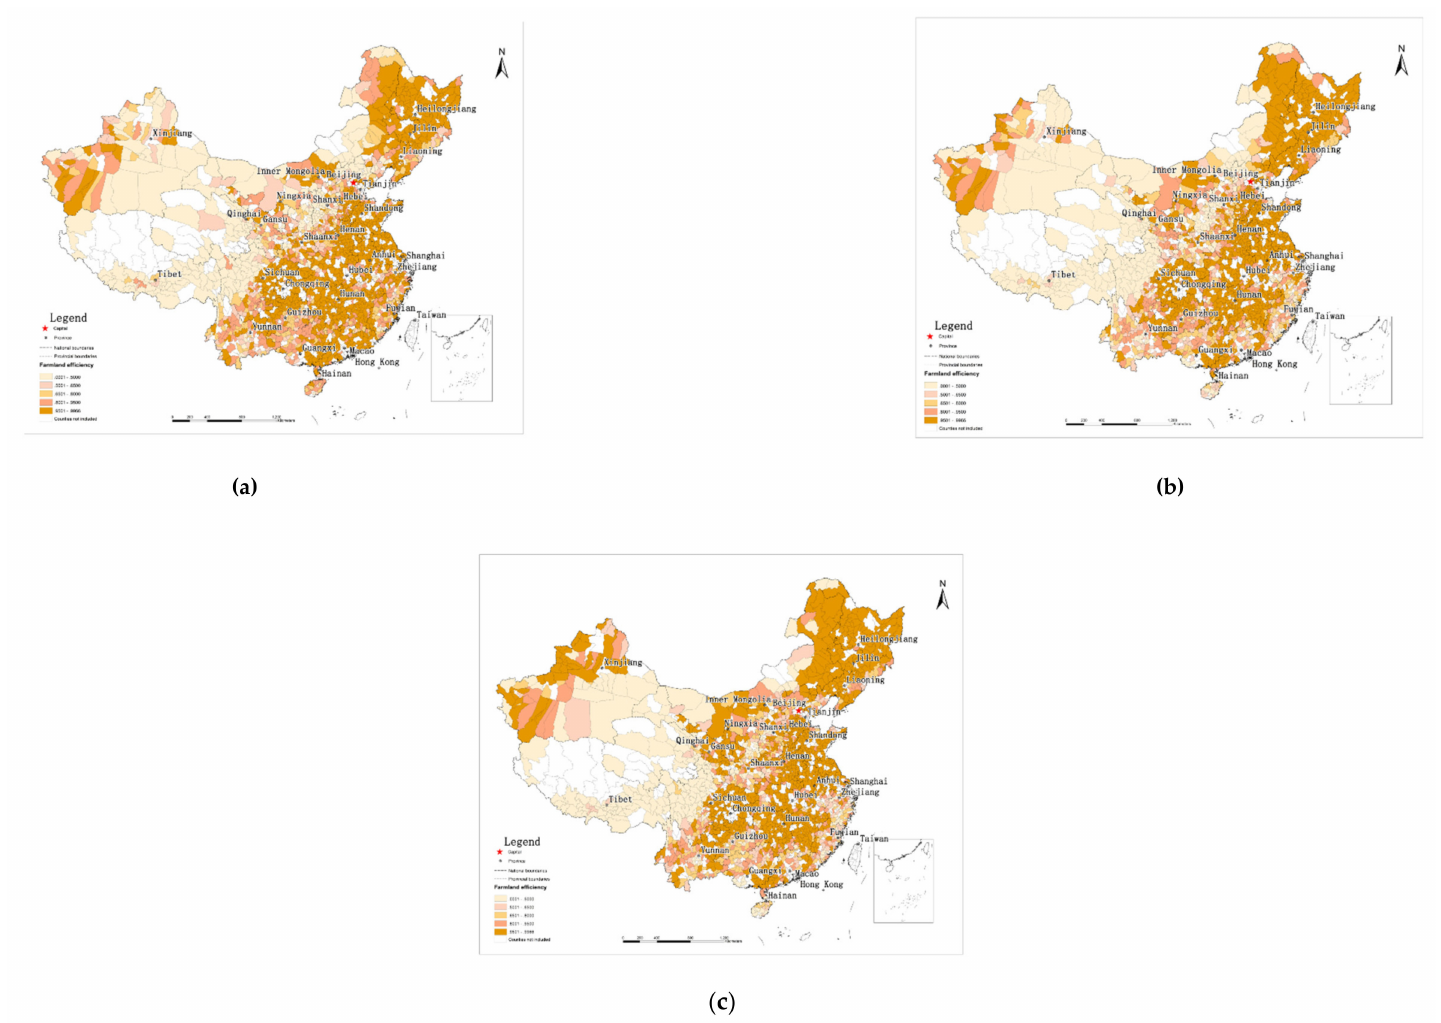
Figure A2. County-level farmland productivity in 2000 ( a ), 2007 ( b ) and 2014 ( c ) in